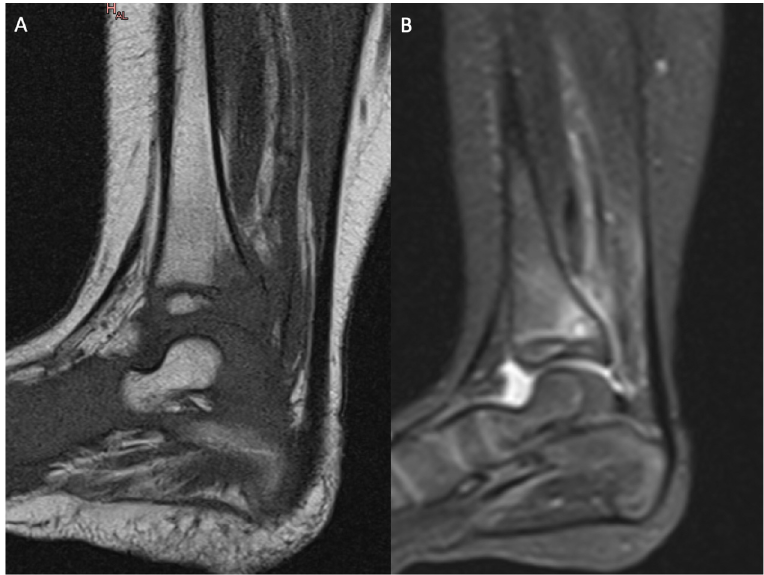
Figure 2. MRI of the left ankle showing primary metaphyseal acute hematogenous osteomyelitis with transphyseal extension to the distal tibia due to Kingella kingae : ( A ) sagittal view of the left ankle with T1 sequence; ( B ) sagittal view of the left ankle with T2 STIR sequence.